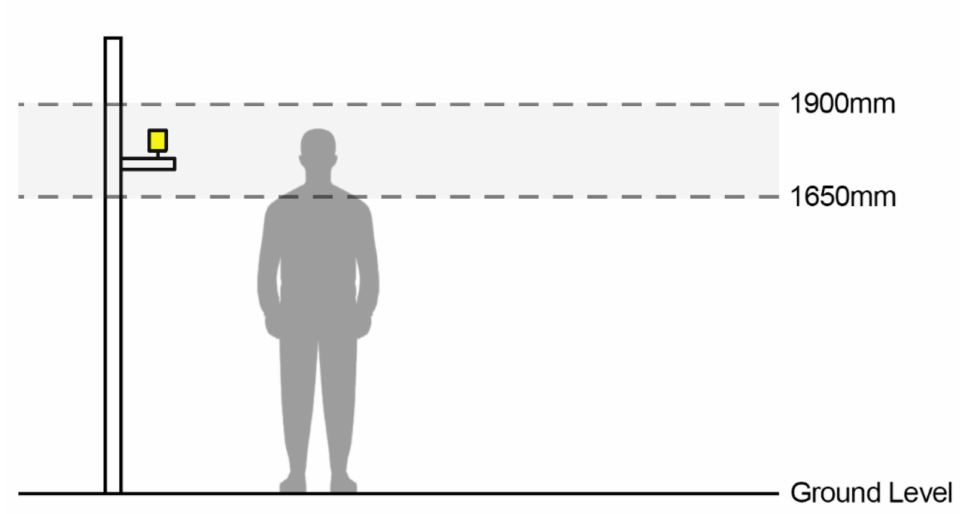
Figure 4. Illustration of PM measuring heights.